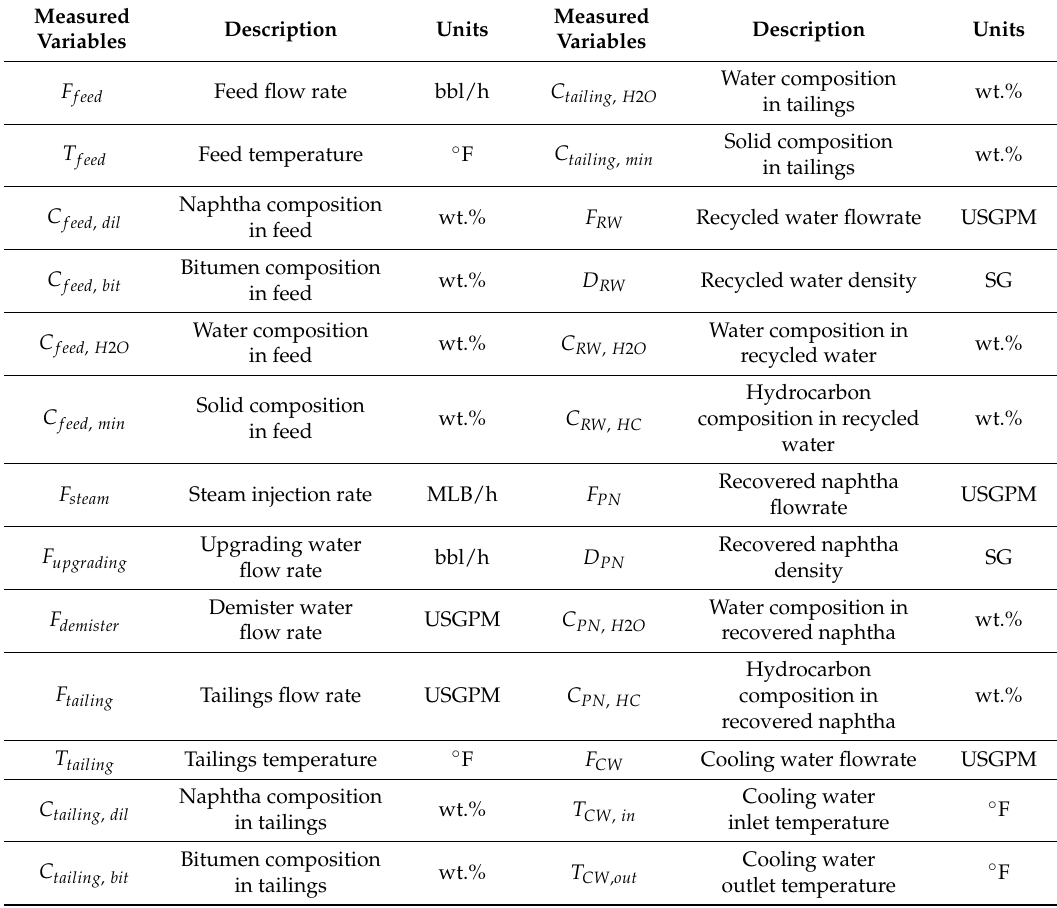
Table 1. NRU stream variables.